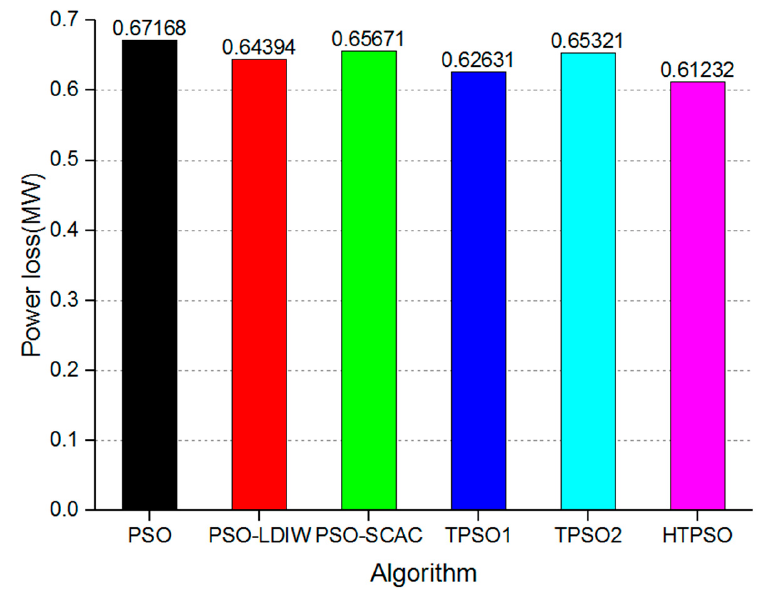
Figure 6. Active power loss diagram of each algorithm.